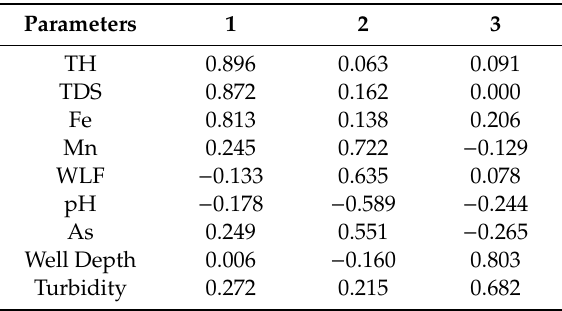
Table 4. Varimax rotated R-mode factor-loading matrix for groundwater of the platform.